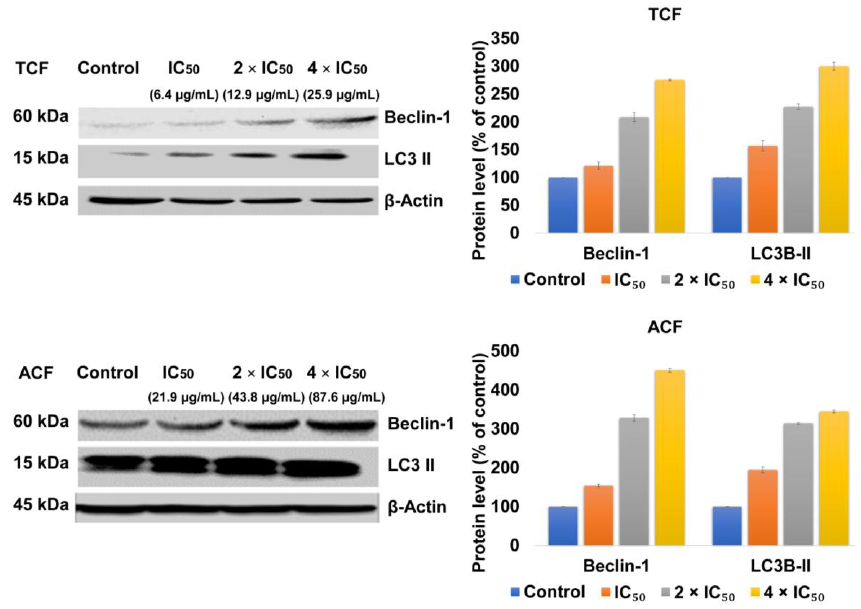
Figure 6. The expression of Beclin-1 and LC3B-II in human NCI-H929 cells treated with 1, 2, 4 × IC 50 of chloroform fractions of T. vulgaris (TCF) and A. lappa (ACF) for 24 h was detected by western blot analyses. The relative protein expression of Beclin-1 and LC3B-II was normalized to β-actin. Control: NCI-H929 cell without treatment.